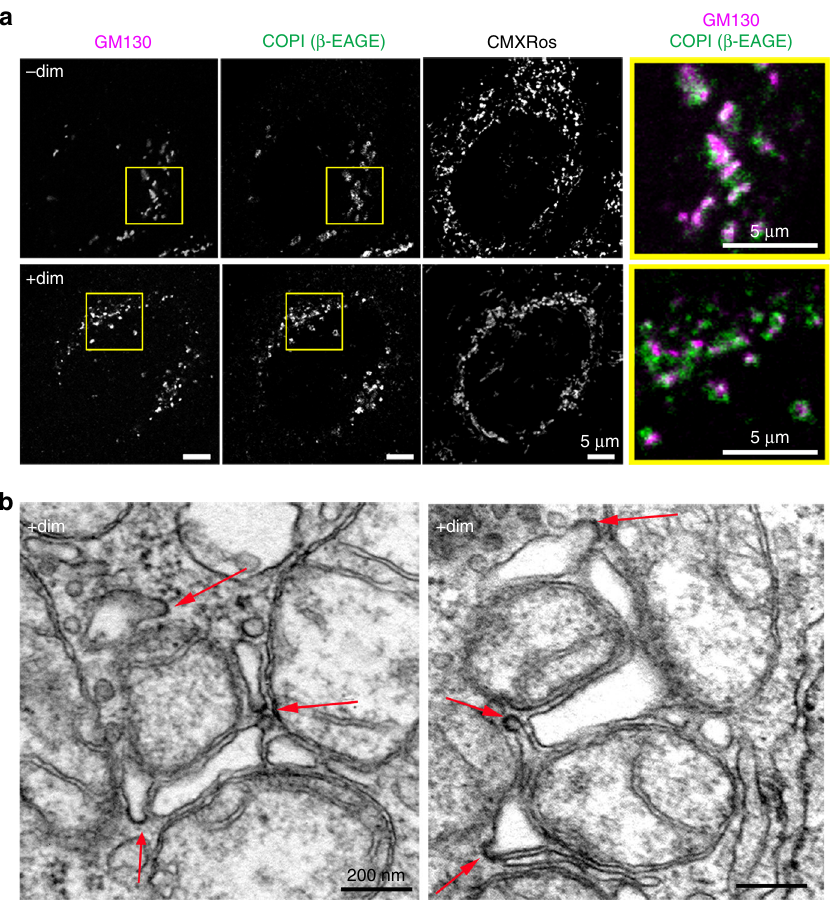
Fig. 3 Land-locked cisternae contain coatomer, coated buds and vesicles. a Confocal images of HeLa cells transfected with GRASP55-FKBP-HA and FRB-Myc-OMP25, then stained for mitochondria and immunostained for GM130 and COPI. Where indicated, cells were treated with dimerizer (2 μ M) for 3 h. Scale bar is 5 μ m. b TEM images of vesicles and budded regions on land-locked Golgi in HeLa cells transfected with GRASP55-FKBP-BFP and FRB-Myc-OMP25 and treated with dimerizer. Scale bar is 200